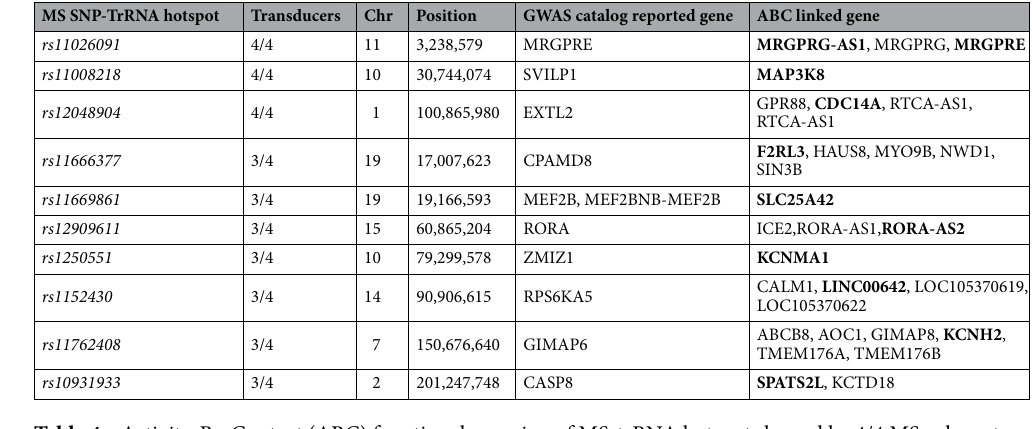
Table 4. Activity-By-Contact (ABC) functional mapping of MS-trRNA hotspots bound by 4/4 MS-relevant transducers or only 3/4 (AID,EBNA2, VDR). Genes who scored the highest ABC score are highlighted in